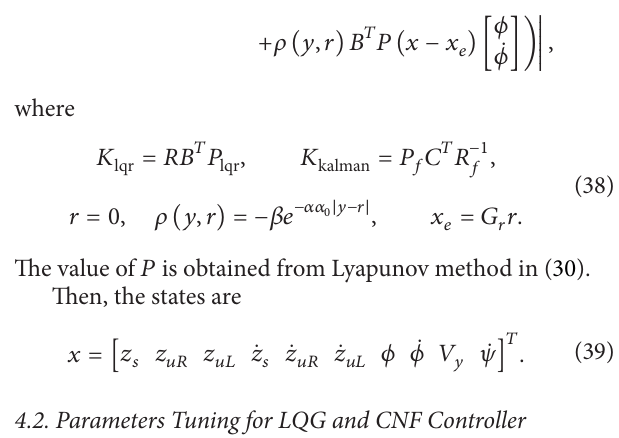
Figure 5: Speed bump